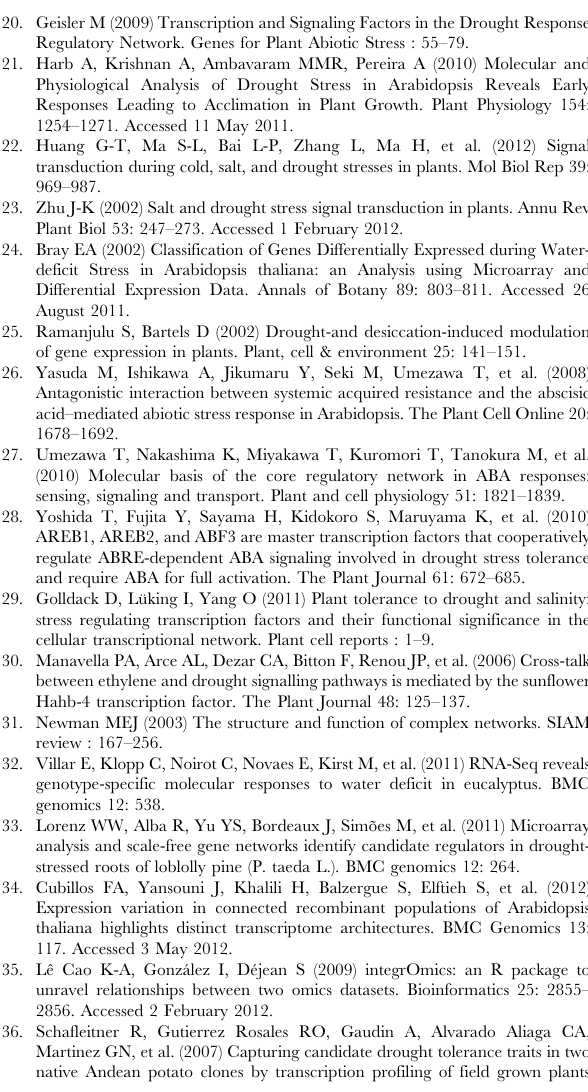
links to phenotypic variables in the Gene-Phenotype network, their GO term assiciated and the GO term enrichment test